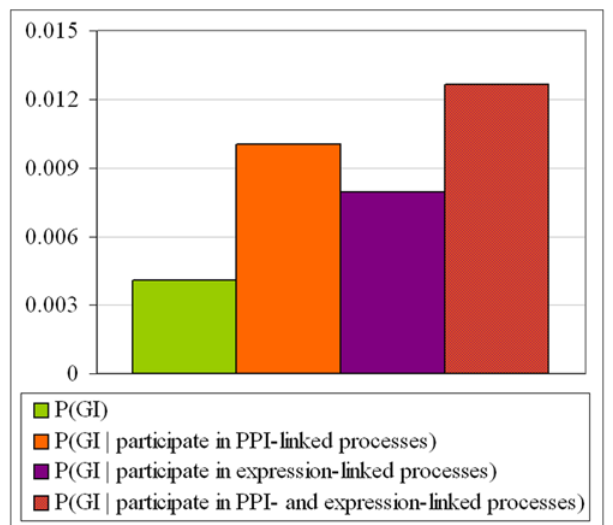
Figure 5. The probability for two genes with known specific biological process (S. cerevisiae) to genetically interact. (i) without prior knowledge; given that the genes participate in (ii) PPI- linked processes, (iii) expression-linked processes and (iv) processes that are both PPI-linked and expression-linked. The total number of genetic interaction that was considered here is 15,228.